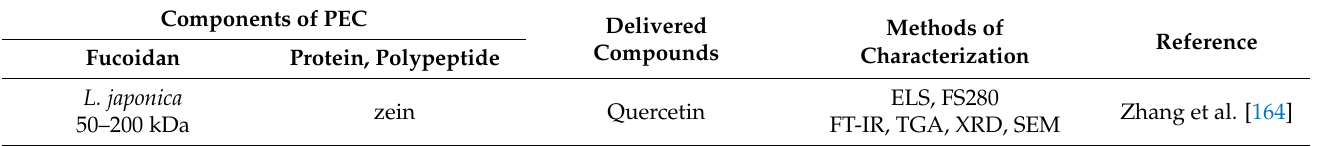
Table 2. Methods of characterization of NPs, obtained by mixing FUC with proteins and/or polypeptides. Components of